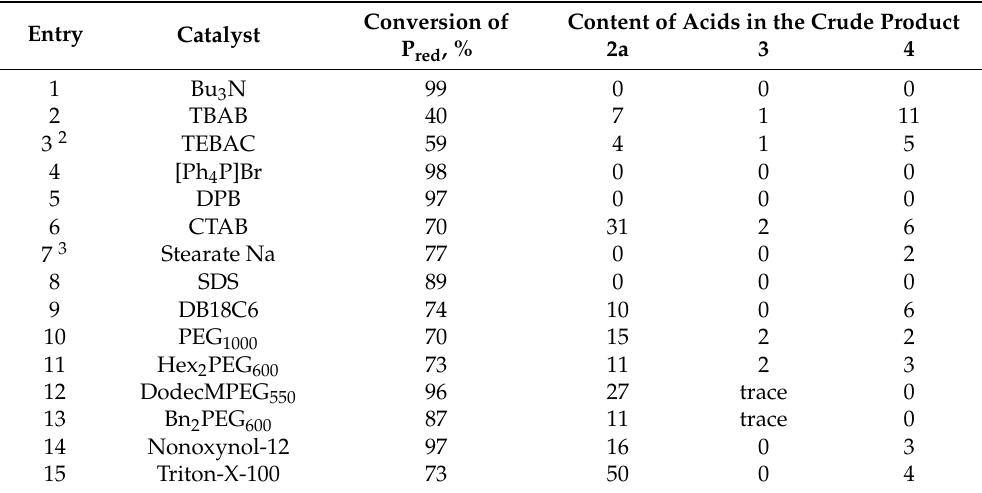
Table 1. Catalyst screening in the phosphinylation of benzyl chloride 1a with red phosphorus 1 .